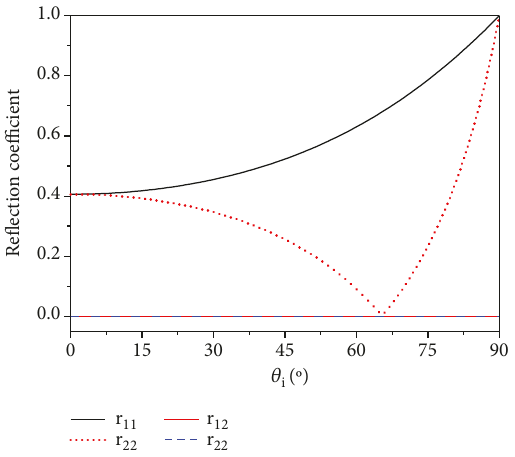
Figure 9: The induced current at the center of the thin wire with di ff erent lengths.